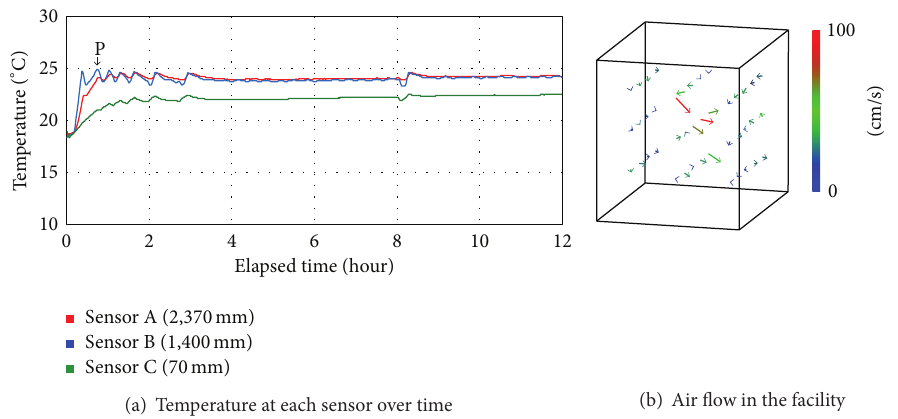
Figure 5: Temperature and air flow in the controlling condition of Case 3.